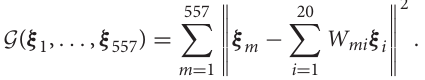
closer to each other and do not represent the right dimensionality of the embedding space. Therefore, it seems that the right dimensionality of the embedding space is three—even